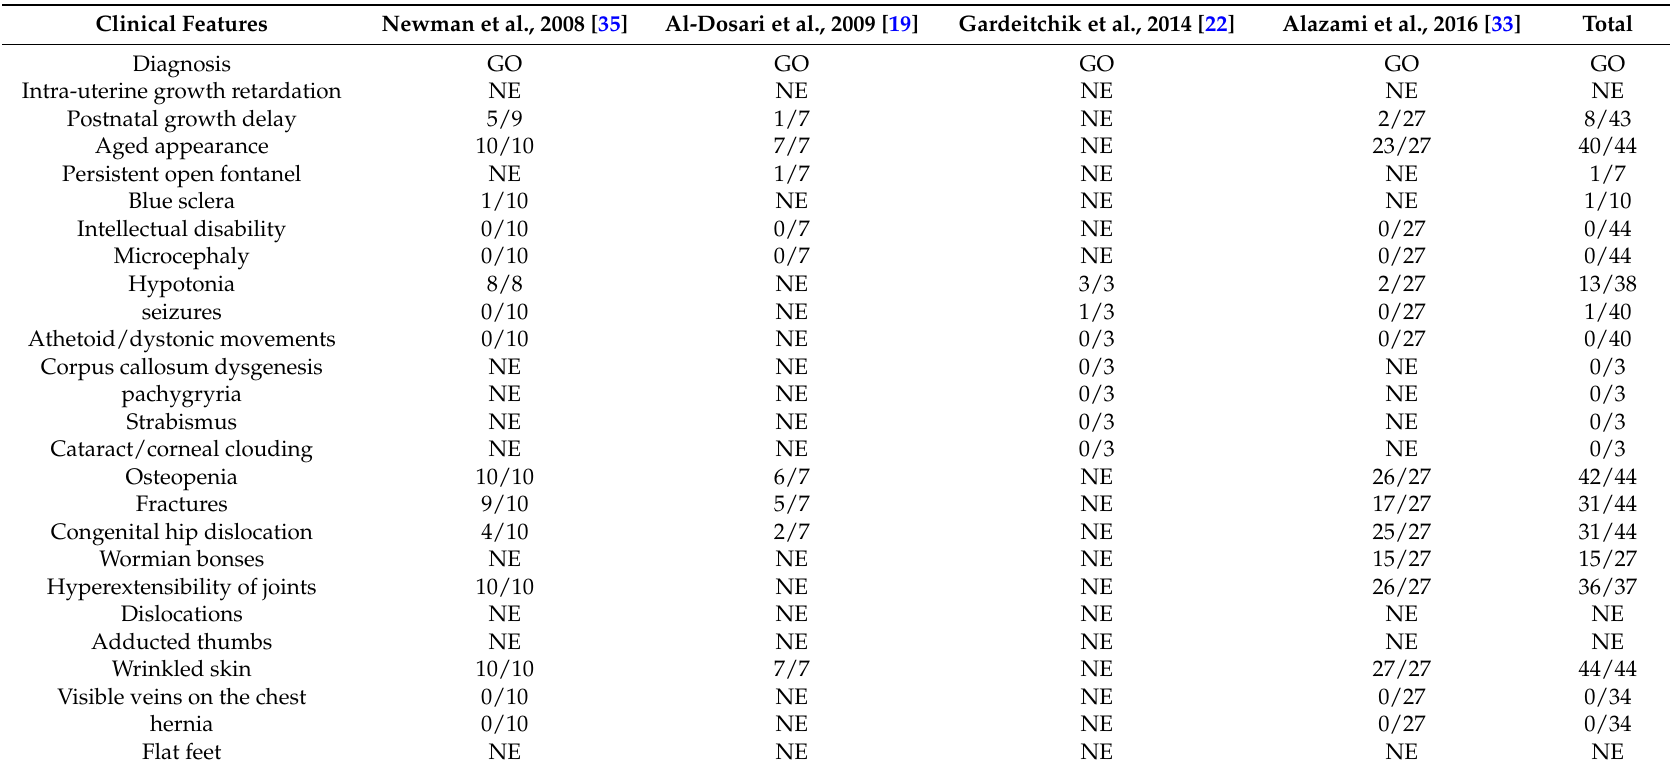
Table A3. Clinical features in Geroderma Osteodysplastica patients reported in the